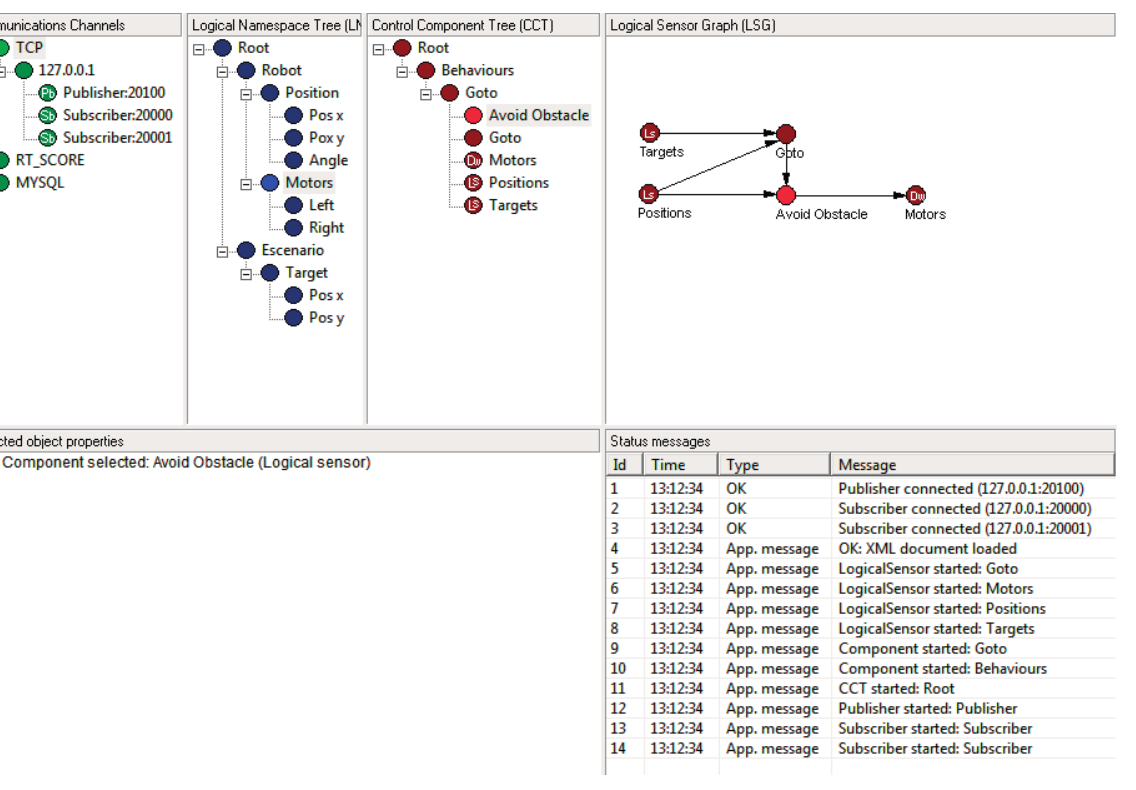
Figure 16. Control components